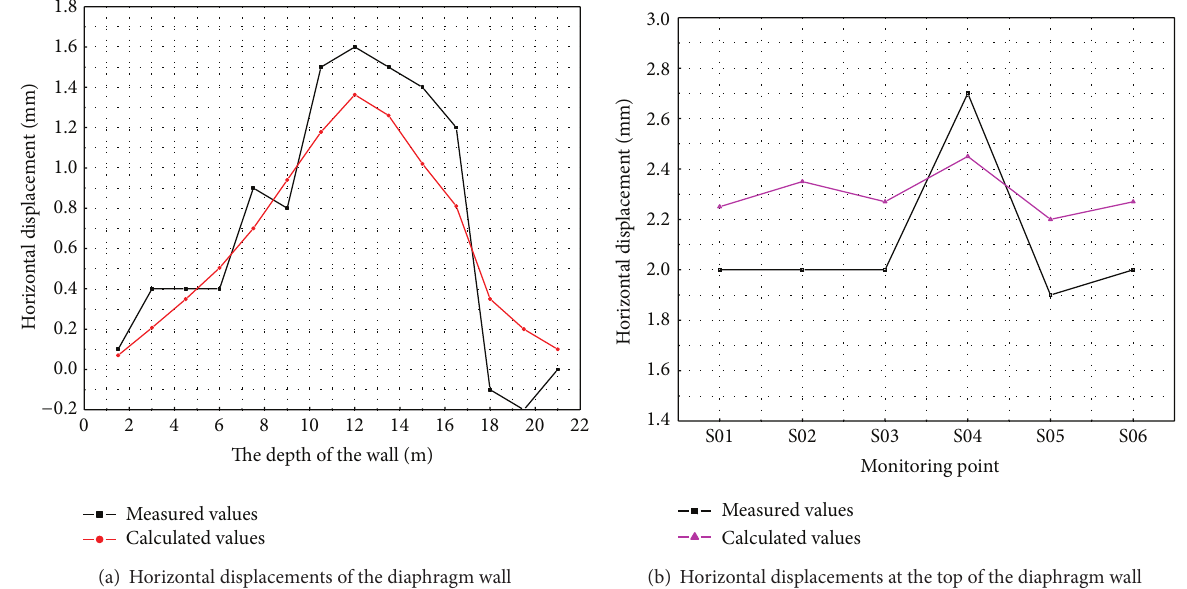
Figure 8: The comparison between measurements and simulation results.